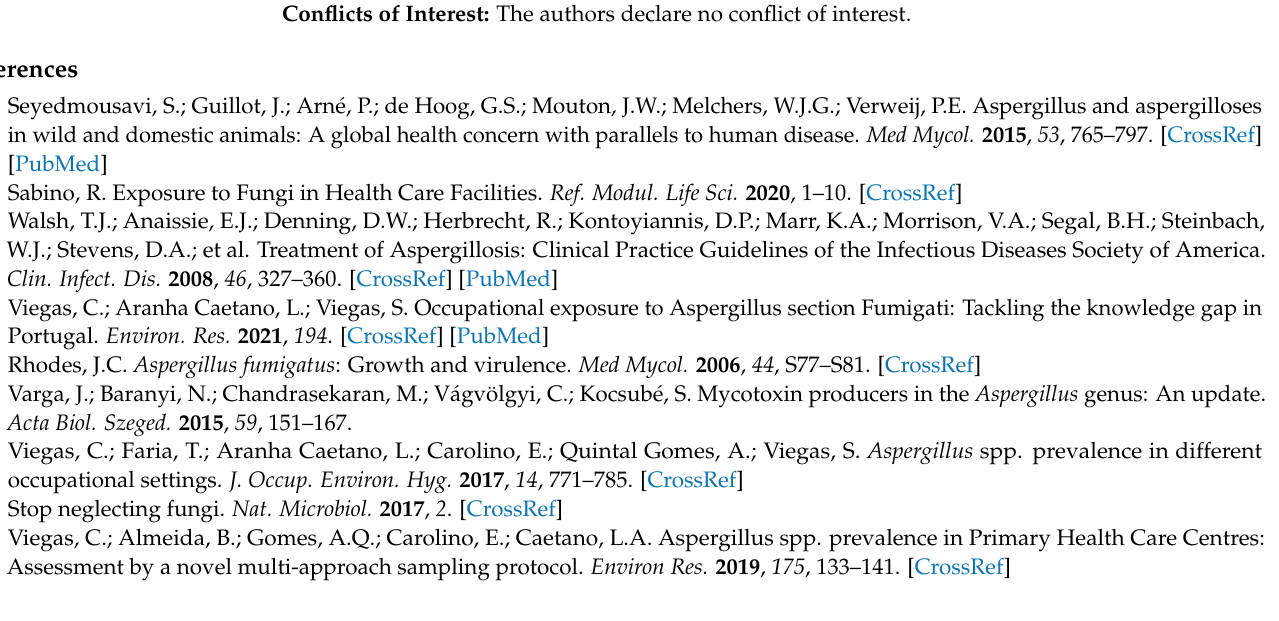
FFH. Table S2. Formulas applied for the calculation of CFU. M − 3 /m − 2 * CFU.m − 2 .day − 1 . Table S3. Aspergillus section Fumigati distribution in each FFH per sampling method. Table S4. Aspergillus section Fumigati prevalence in positive samples from FFH in MEA and DG18. Table S5. Identification and detection of the Aspergillus section Fumigati in the assessed